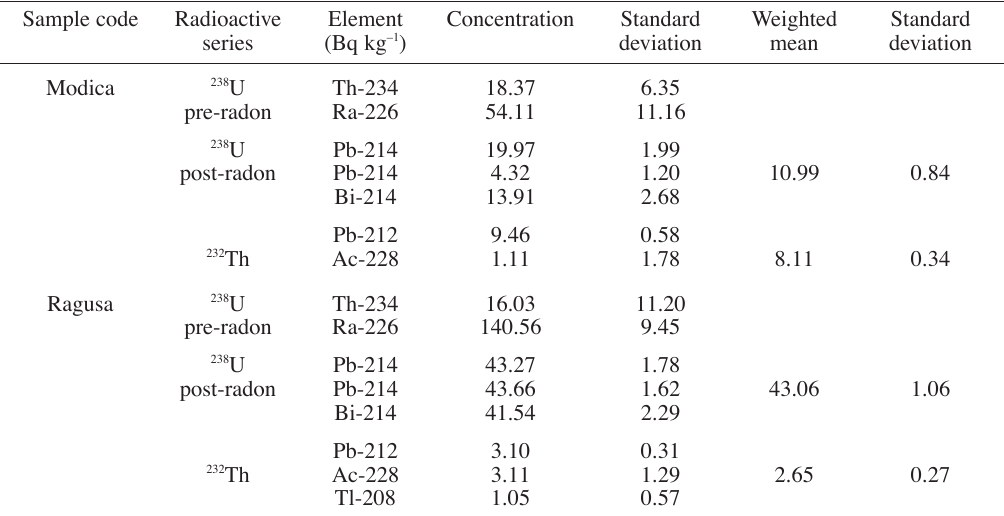
Table II. Radionuclides amount in the soil samples. Sample